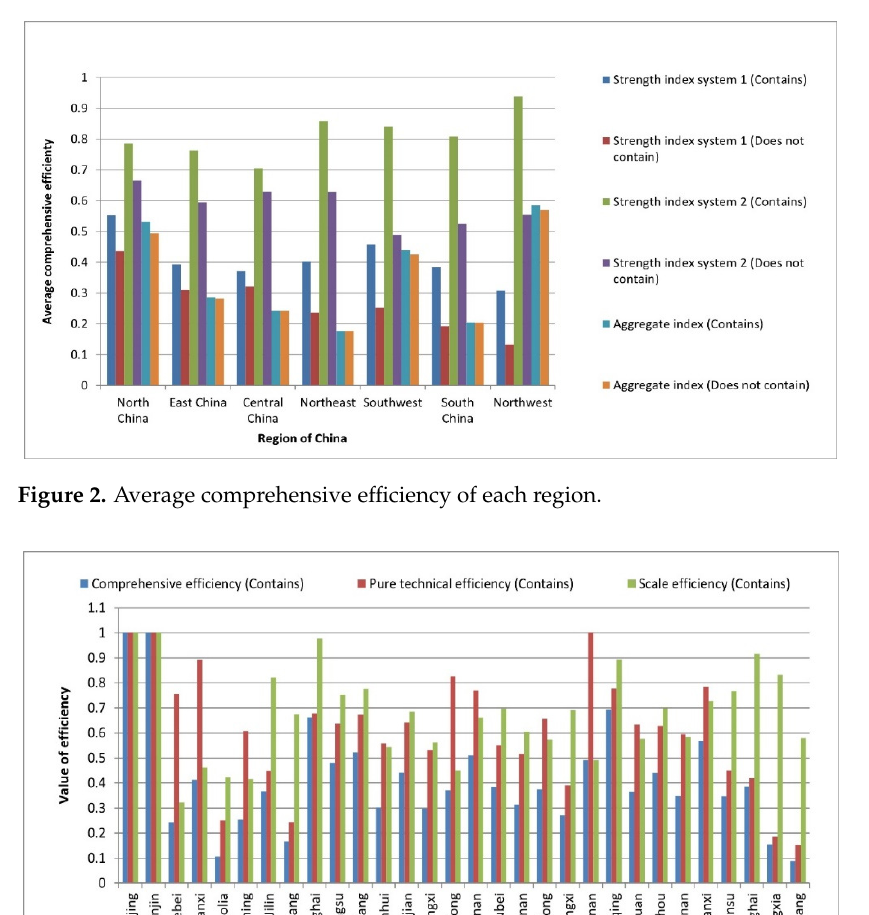
Figure 5. Efficiency values of quantity index. According to the data in Table 2, in the intensity index system with per capita culti ‐ vated land area as the food input index, the two provinces with a comprehensive effi ‐ ciency value greater than 0.9 were Beijing and Tianjin. The four provinces with the lowest comprehensive efficiency value were Shanxi, Jiangsu, Qinghai, and Xinjiang. The